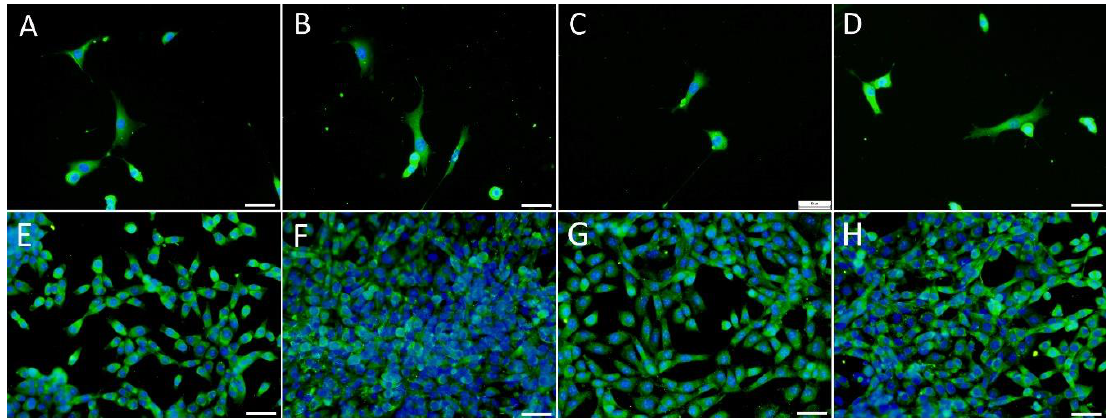
Figure 11. The immunofluorescence staining of vinculin on day 1 following seeding ( A – D ) and type I collagen on day 7 following seeding ( E – H ) in the 3T3 fibroblasts cultured in the DMEM with 2% FS without PL ( A , E ) and with 1% PL ( B , F ), the pure PVA nanomats ( C , G ) and the PVA–PL nanomats ( D , H ). The cell nuclei were counterstained with Hoechst 33258. Olympus IX71 epifluorescence microscope, DP71 digital camera, obj. × 20, scale bar = 50 µm. The same exposure time was used in the taking of the images.